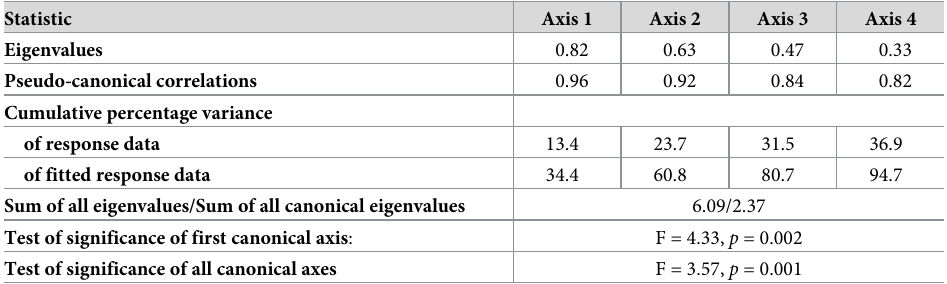
Table 2. Summary statistics for CCA performance between environmental factors and zooplankton.